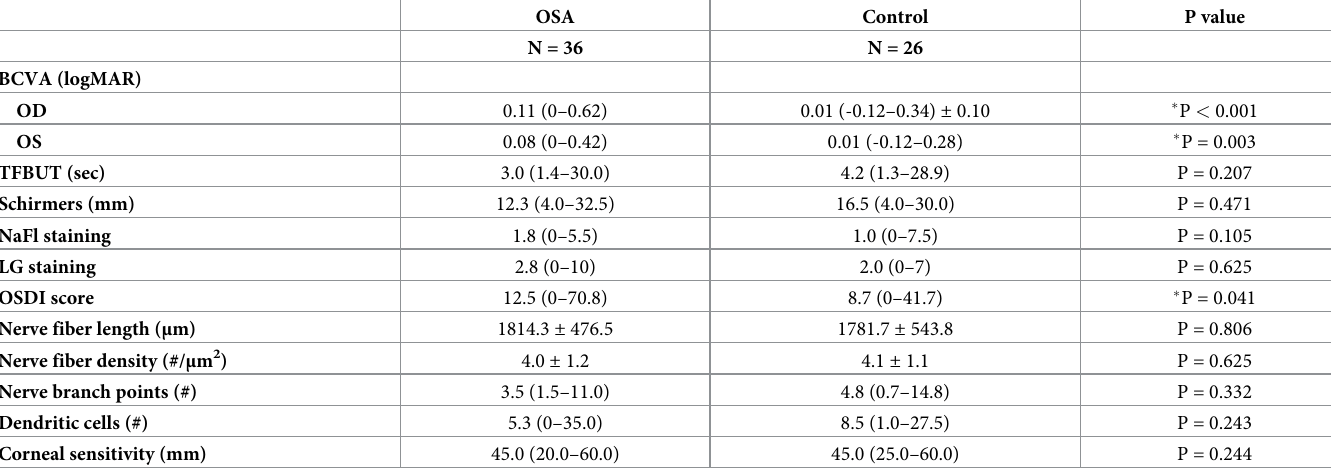
Table 3. Cornea and ocular surface metrics.